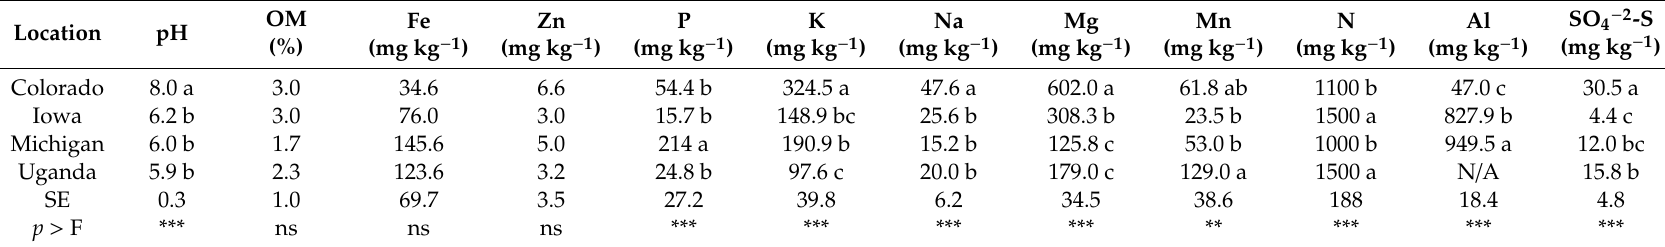
Table 3. Elemental concentrations, pH and organic matter (OM) of soil for experimental sites in Colorado, Iowa, Michigan and Uganda after fertilization and prior to planting in 2017 and 2018.